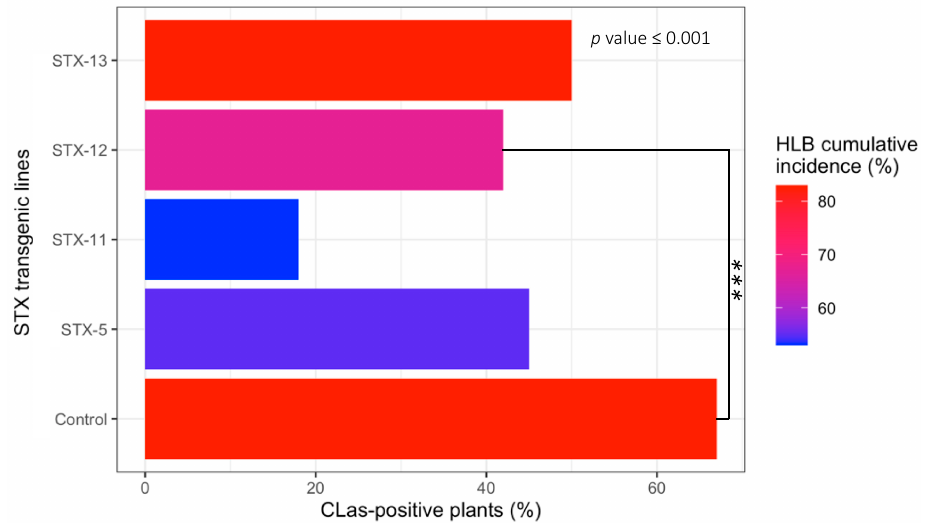
Figure 4. Cumulative incidence of huanglongbing (HLB, %) and ‘ Candidatus Liberibacter asiaticus’ ( C Las)-positive plants (%) of STX IA transgenic and non-transgenic Pera sweet orange plants. Significance level: ***, p ≤ 0.001.